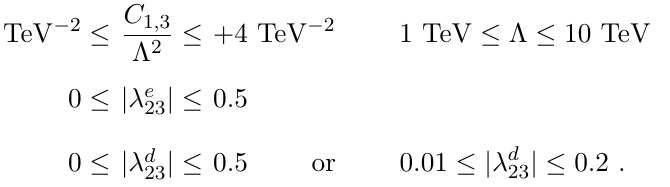
predictions when scanning the parameter space of D ( (cid:3) ) anomaly D ( (cid:3) )